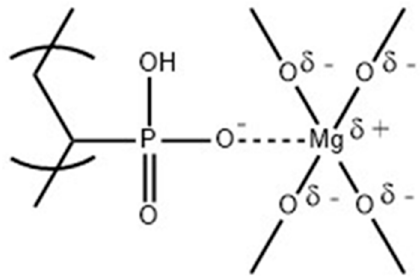
Figure 4. Proposed structure of PVPA/MgO complex.